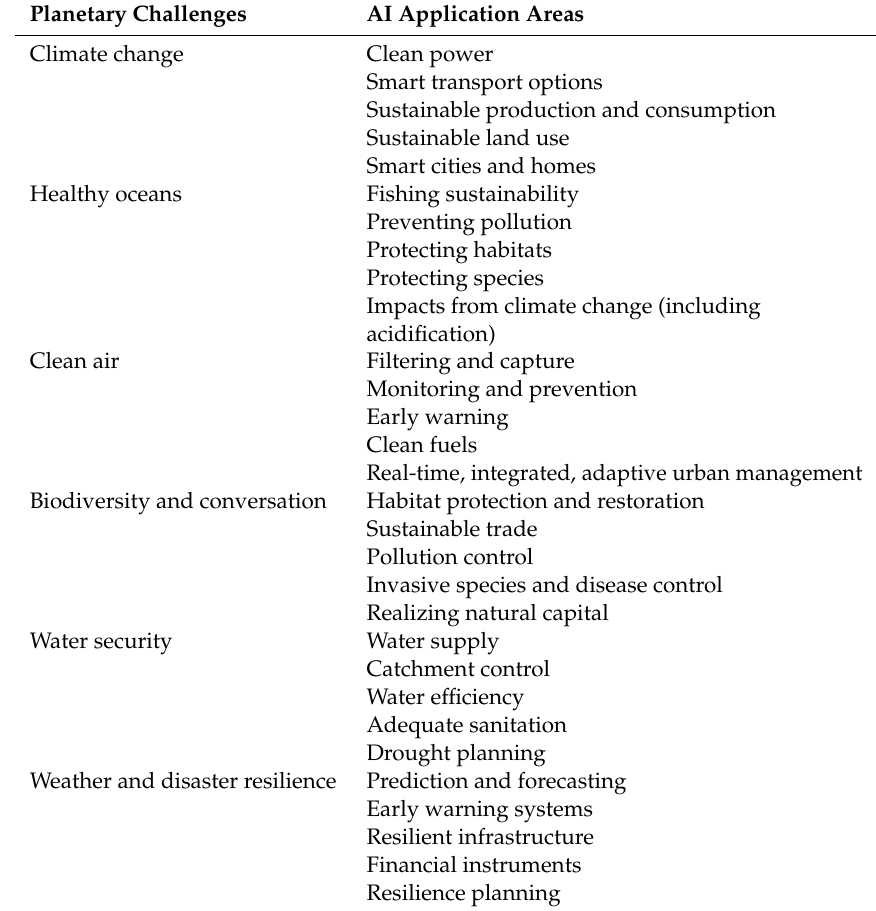
Table 1. AI application areas for addressing planetary challenges, derived from World Economic Forum